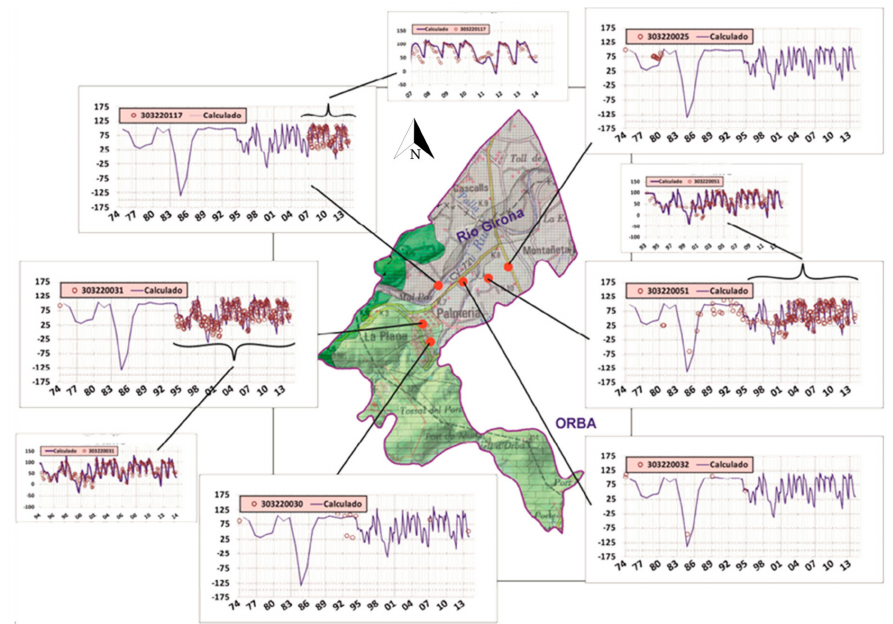
Figure 7. Simulated levels (continuous line) vs. observed levels (red dots) for some wells of the Orba aquifer in Alicante. From